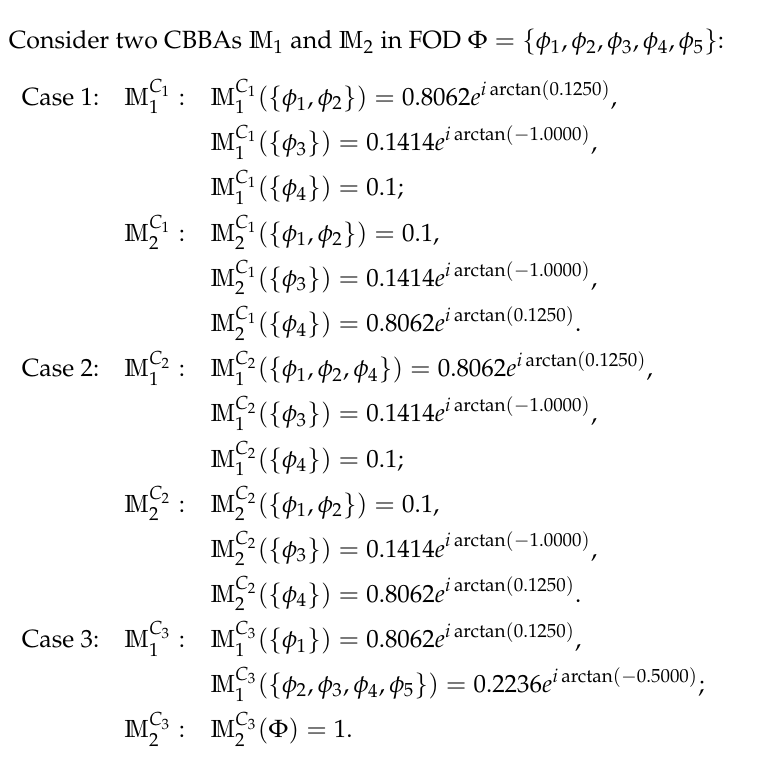
Figure 1. The conflict measures in Example